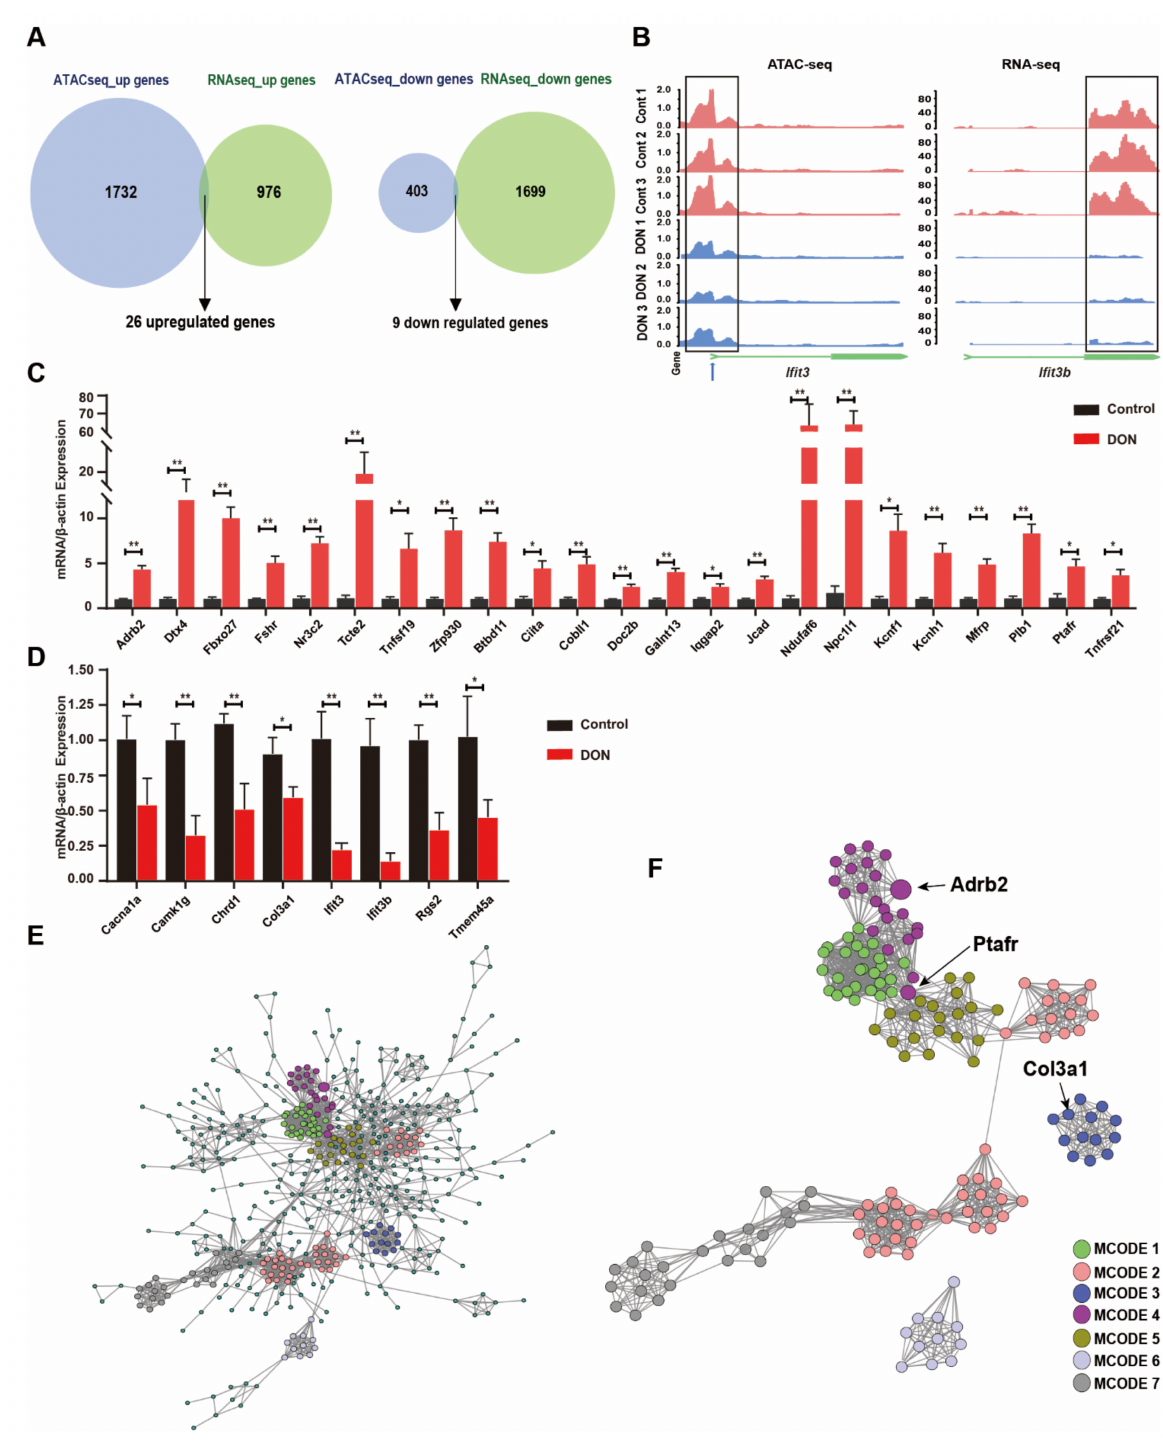
Figure 4. The association between the specific chromatin-accessible regions and gene expression in murine ovarian GCs upon DON exposure. ( A ) Venn diagram showing genes associated with the chromatin-accessible regions and differentially expressed genes. ( B ) Changes in chromatin accessibility downstream and expressive level of the Ifit3b gene. The predicted TFs binding sites are shown with a blue arrow. ( C ) Realtime RT-PCR analysis of the relative expression of the DGEs which collaborative filtering from RNA-seq data and ATAC-seq data. Each bar represents the mean ± SEM. * p < 0.05, ** p < 0.01 compared with the control group ( t -test). ( D ) Protein–protein interaction (PPI) network of proteins encoded by differentially expressed genes (DEGs). ( E , F ) Modules selected from PPI network using MCODE. Degrees > 6 was set as the cutoff criterion. Nodes represent DEGs; lines represent interaction relationships between